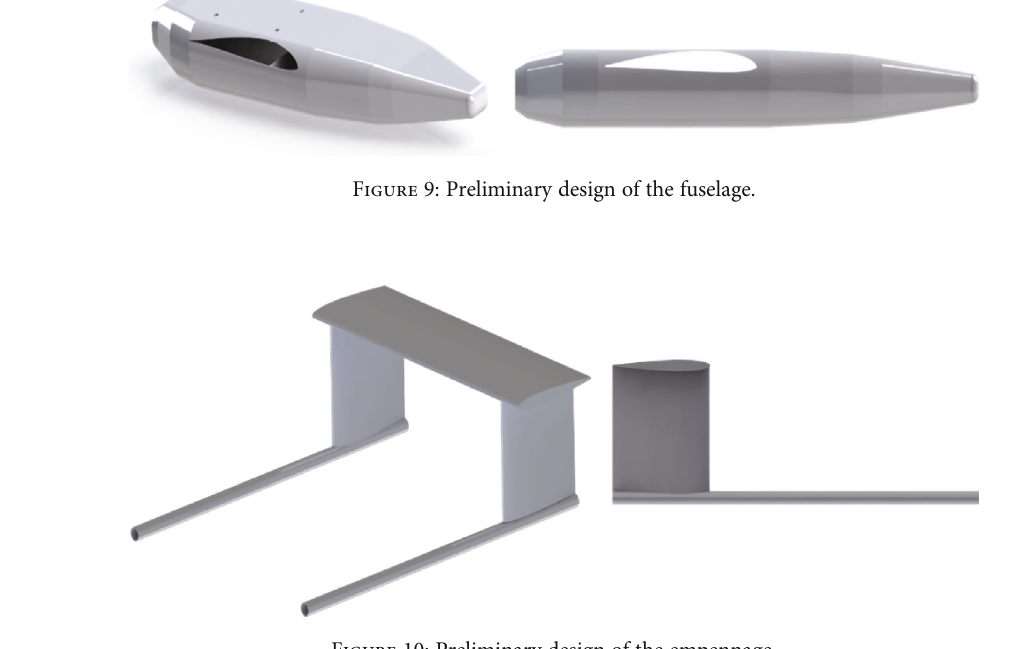
Figure 10: Preliminary design of the empennage.